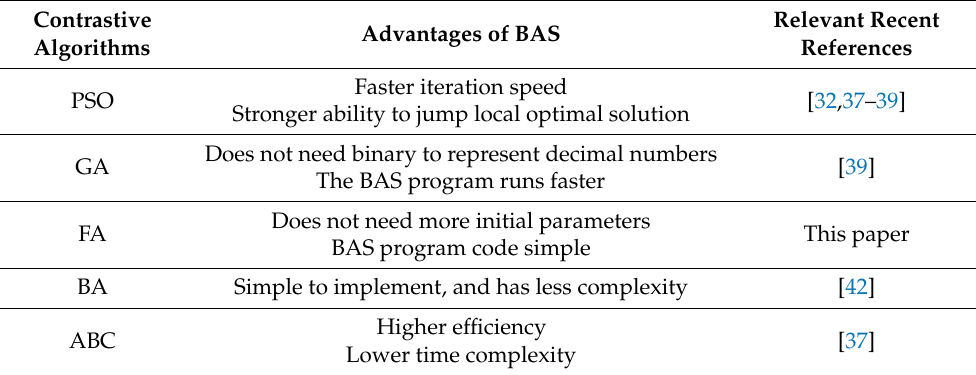
Table 2. Uniqueness of BAS among